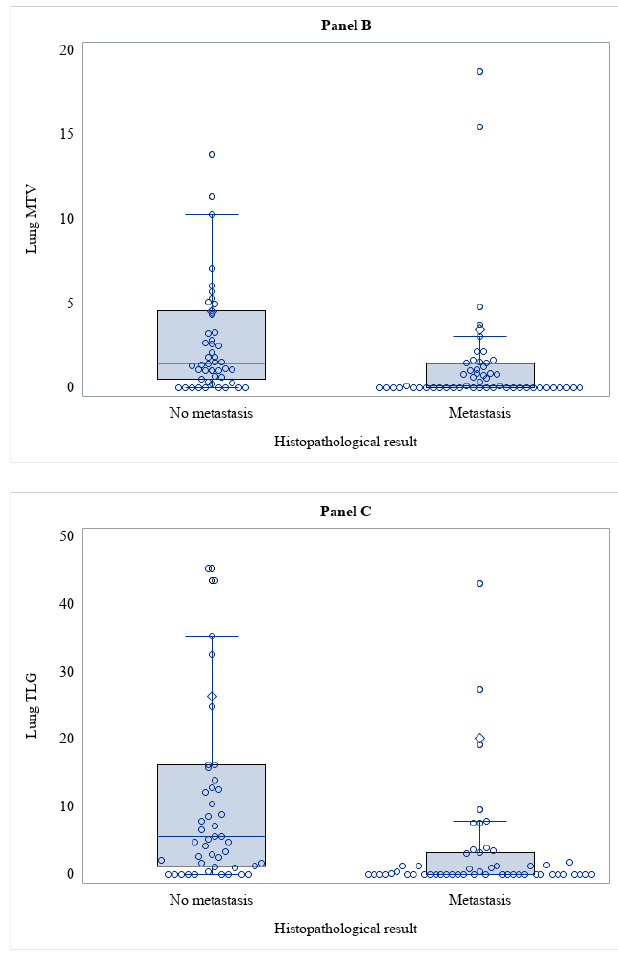
Figure 2. Distribution of SUVmax (Panel ( A )), MTV (Panel ( B )), TLG (Panel ( C )) among lesions with and without metastasis ( n = 107).